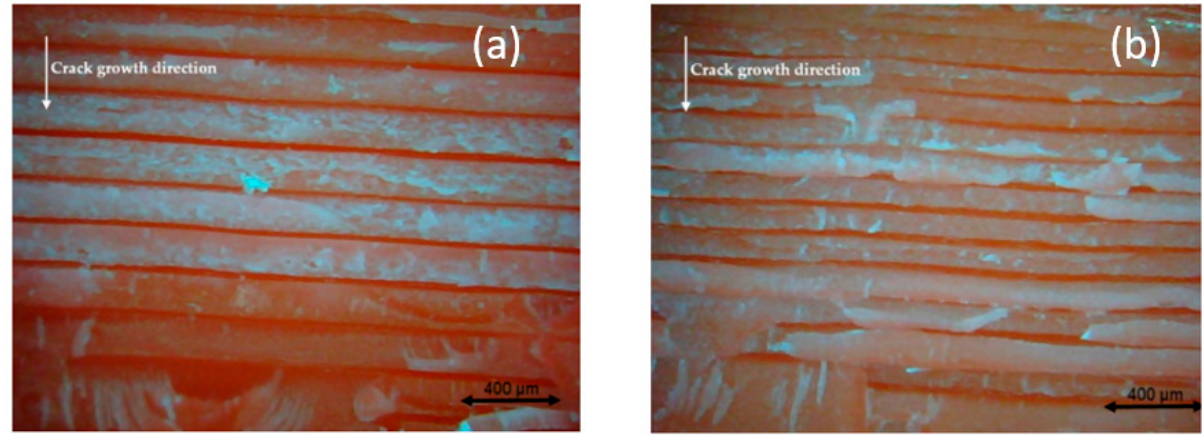
Figure 11. Comparison between the influence of different layer thicknesses of FDM ABS, printed with a 0.6-mm nozzle size, Y building orientation, and layer thickness ( a ) 0.15 mm and ( b ) 0.10 mm [33].